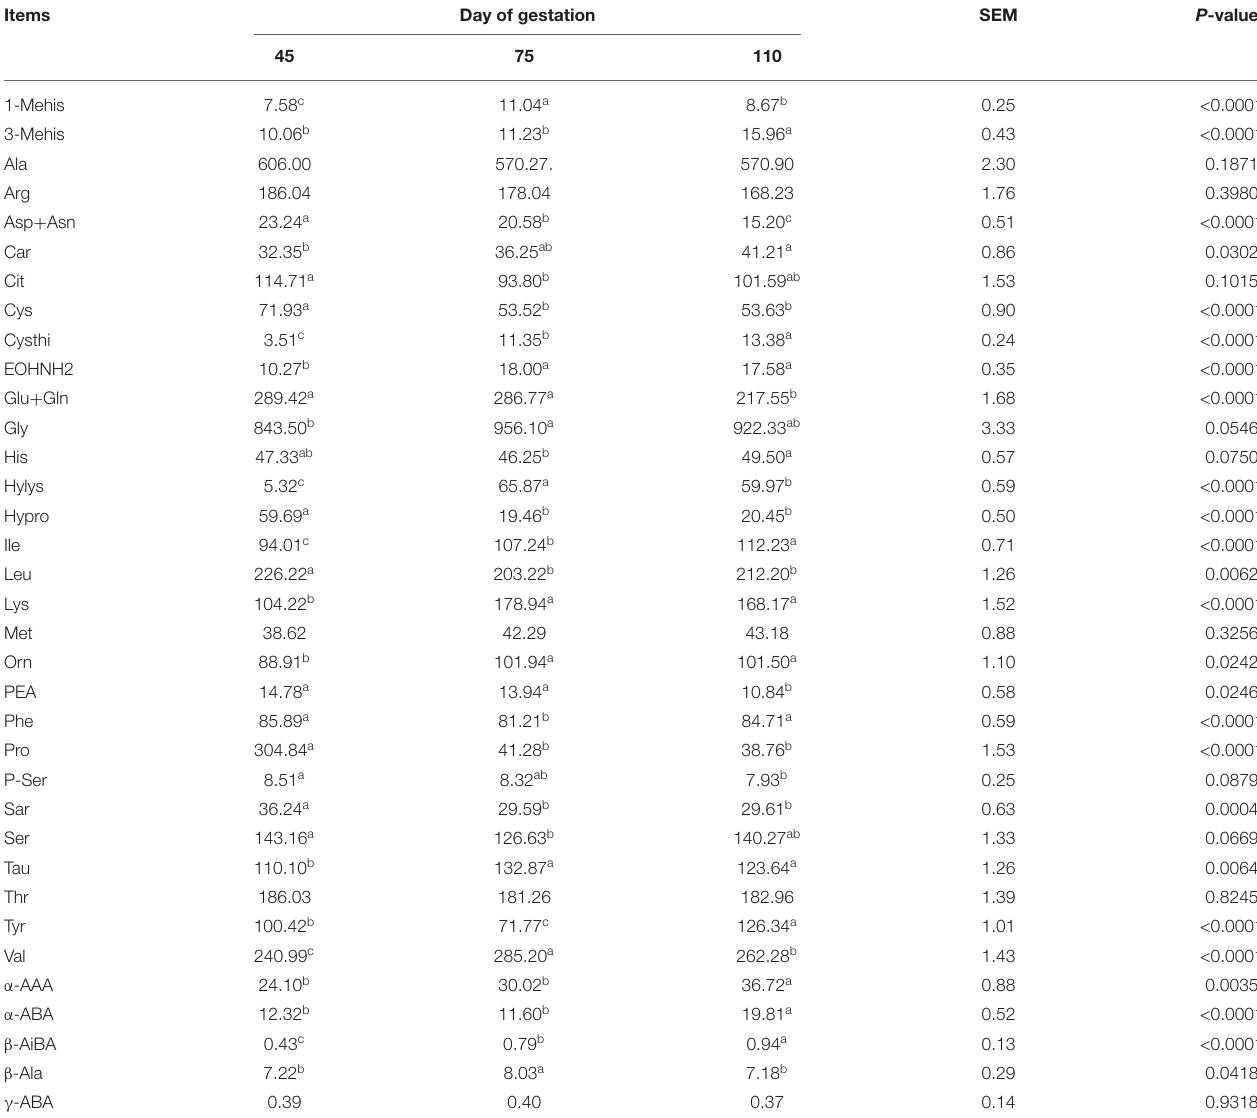
TABLE 5 | Free AA profiles in plasma of Huanjiang mini-pigs at different gestation periods